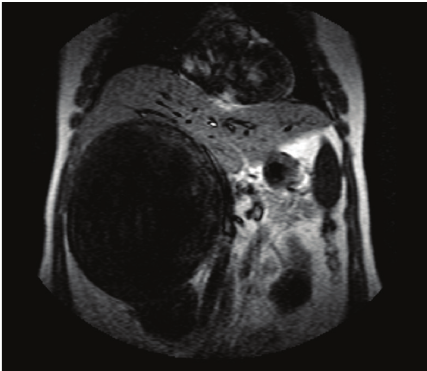
Figure 4: Intraoperative image showing the close relation between IVC and the mass.